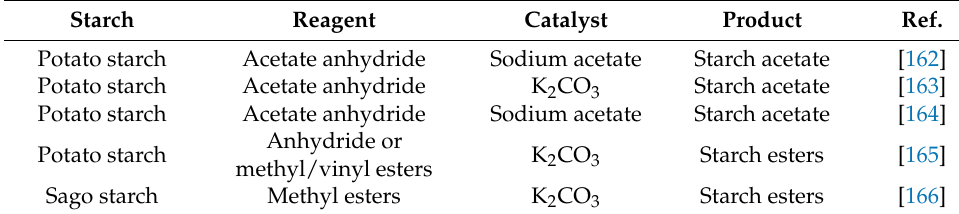
Table 4. Esterification or transesterification of starch in supercritical CO 2